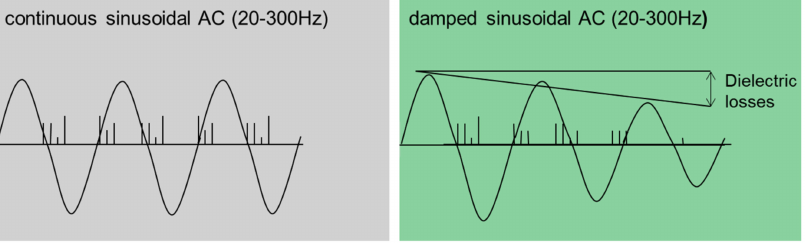
Figure 2. Visualization of onsite energizing and diagnosis at continuous AC (ACRT) and at damped AC (DAC)